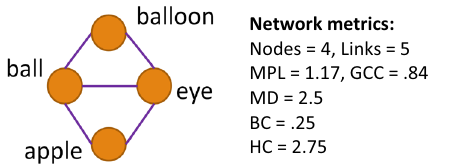
Figure 2. An example noun-feature network with four nodes (words) and five links (indicating multiple overlapping semantic features between